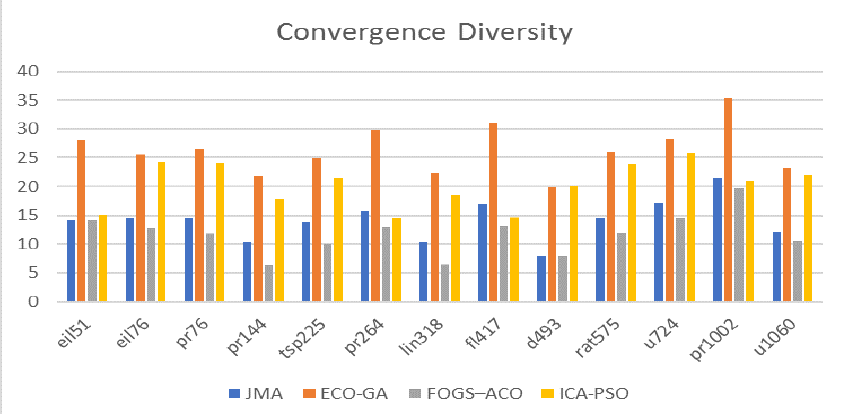
Figure 9. Convergence